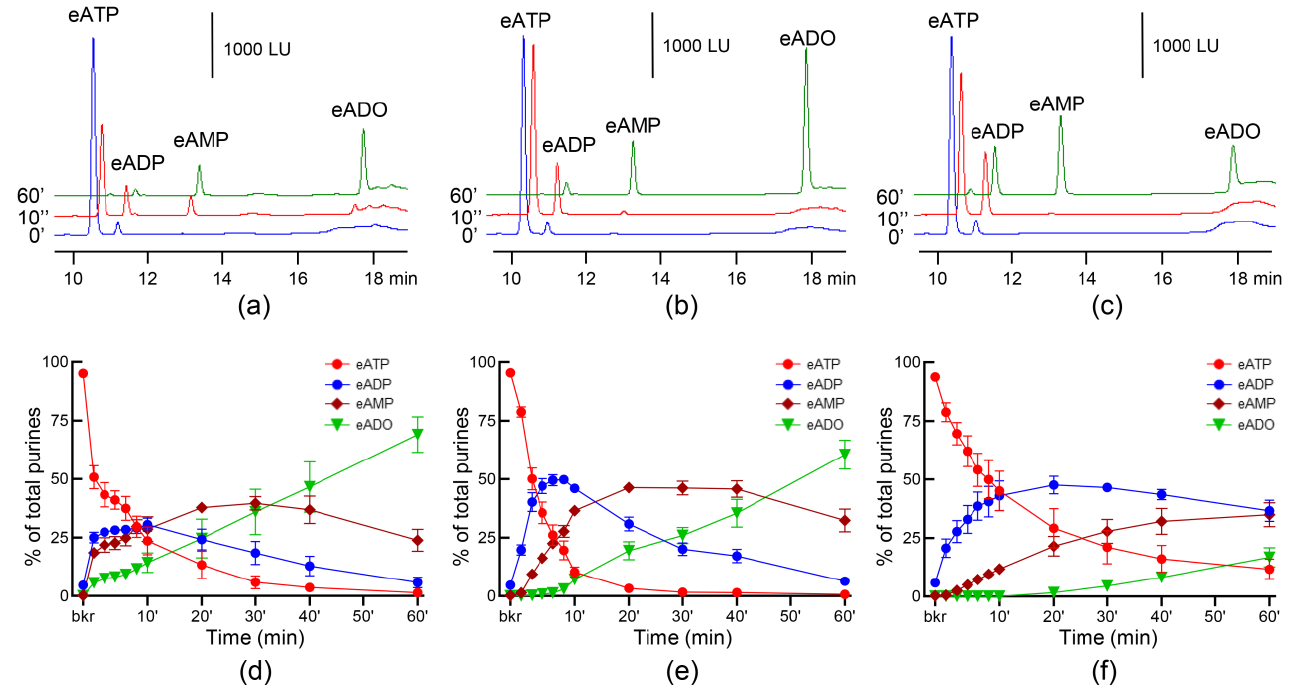
Figure 1. Hydrolysis of eATP in bladder lumen of detrusor-free bladder preparations by membrane-bound and soluble nucleotidases. Original chromatograms of eATP in beaker (blue, 0 ′ , no enzymes present) and at 10 s (red) and 60 min (green) after starting the enzymatic reactions in the bladder lumen ( a ), in ILS collected at the end of bladder filling ( b ), and in ILS filtered through 10 kDa MWCO membranes ( c ). Note the decrease of eATP substrate and the increase or appearance of the e-products eADP, eAMP and eADO. Summarized data showing time-courses of the degradation of eATP in the bladder lumen, n = 4–6 ( d ), in ILS collected at the end of bladder filling, n = 6–14 ( e ), and in ILS collected at the end of bladder filling and filtered through 10 kDa MWCO membranes, n = 3 ( f ); n , number of bladders preparations. eATP, eADP, eAMP and eADO are presented as percentages of total purines (eATP + eADP + eAMP + eADO) present in reaction solutions at each time point for the duration of 1